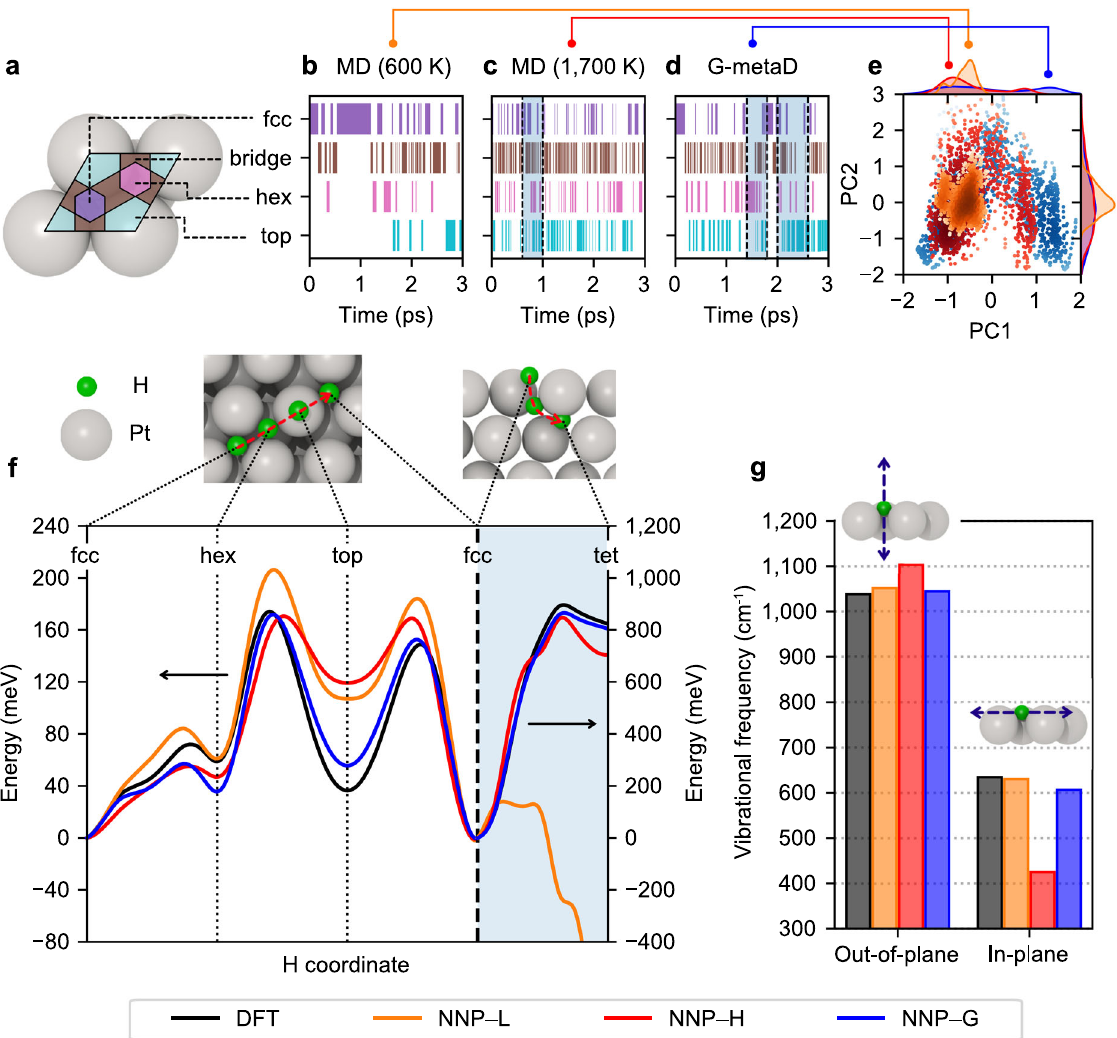
Fig. 2 Sampled con fi gurations and performances of the corresponding NNPs. a Characteristic area on Pt(111) surface. b – d The classi fi cation of H sites along the time for MD at 600 K, 1700 K, and G-metaD at 600 K, respectively. The shaded area means that the H atom stays in the sublayer. e Distribution of sampled points of H atom on principal components axes. f The minimum energy paths along fcc → hex → top → fcc → tet (subsurface tetrahedral site). g Two vibrational frequencies of the H atom at the fcc site. NNP-L, NNP-H, and NNP-G stand for the NNP trained over trajectories from MD at 600 K, 1700 K, and G-metaD at 600 K, respectively. (The atomic con fi gurations are visualized by OVITO 62